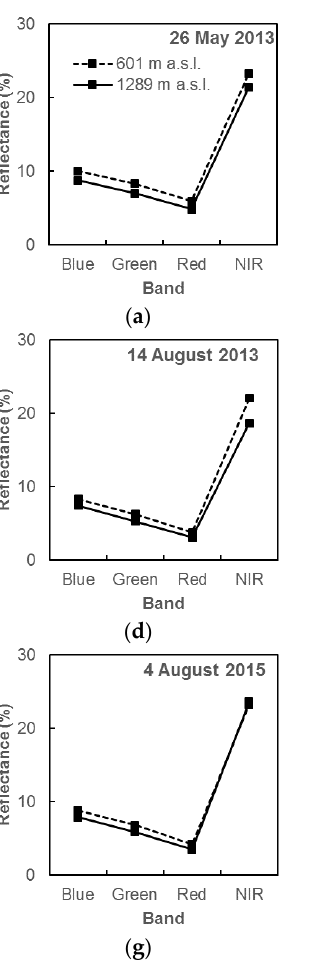
Figure 4. Reflectance of ECF pixels at two different altitudes (601 m a.s.l. and 1289 m a.s.l.) before atmospheric correction ( a , d , g , j ), after elevation-dependent DOS ( b , e , h , k ), and after the application of additional offset ( c , f , i , l ) for Landsat OLI sub-images dated 26 May 2013, 14 August 2013, 4 August 2015, and 18 May 2016, respectively. The Minnaert correction method was effective in removing most of the slope shadows in the mountainous terrain (Figure 5). The major topographic features were no longer apparent, although a few shadows could still be detected. For successful implementation of the topographic correction, the selection of pure-pixel samples of the mixed forest randomly distributed in the study area was crucial. The effectiveness of the topographic correction was especially notable in two August sub-images because of the relatively low solar elevation and, consequently, stronger shadow effects in the mountainous landscape.